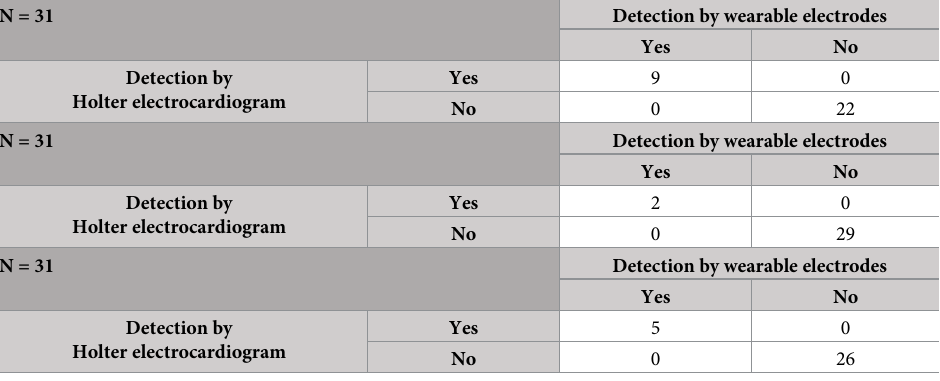
Table 3. Detection of arrhythmias. A. Detection of atrial fibrillation. B. Detection of non-sustained ventricular tachy- cardia. C. Detection of premature ventricular contractions of Lown’s grade > II. N = 31